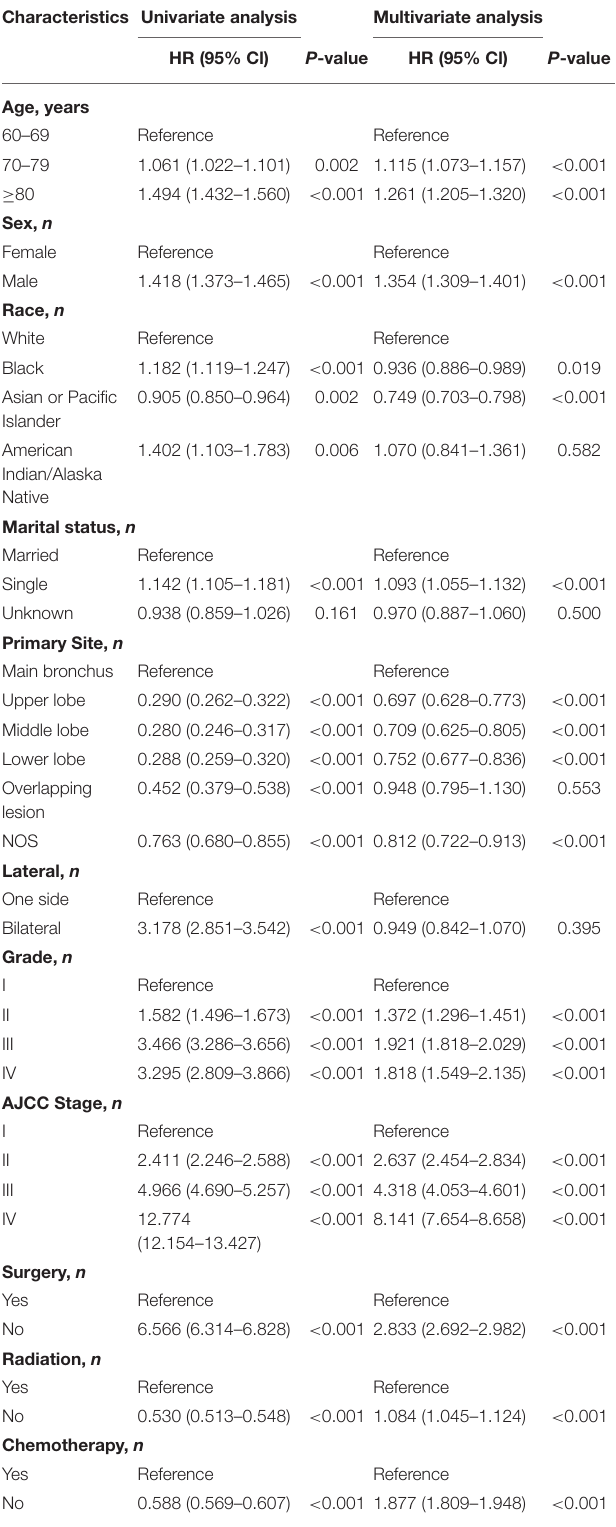
TABLE 2 | Cox regression analysis based on all variables for cancer-specific survival (Training Cohort). Characteristics Univariate analysis Multivariate